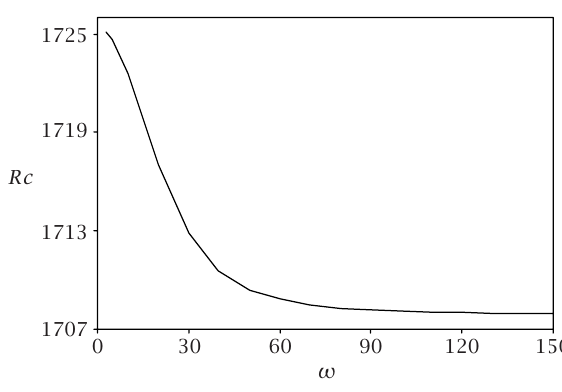
Figure 4.1 . Variation of Rc with ω : P = 0 . 1, ε = 0 . 1, and a = 3 . 1168.